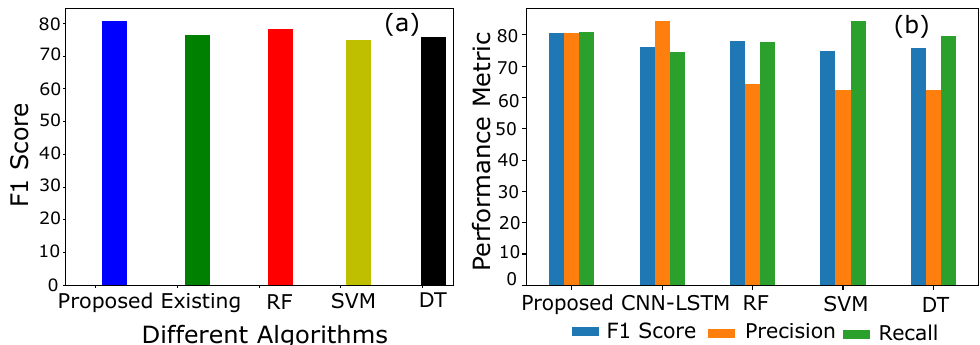
Figure 7. ( a ) F1 Score of different models. ( b ) Comparison of F1 Score, precision and